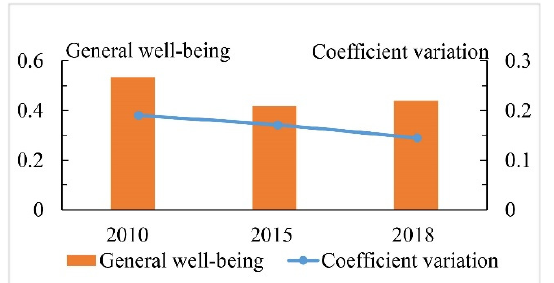
Figure 5. Changing trend of human well-being in Guanzhong Plain urban agglomeration from 2010 to 2018.